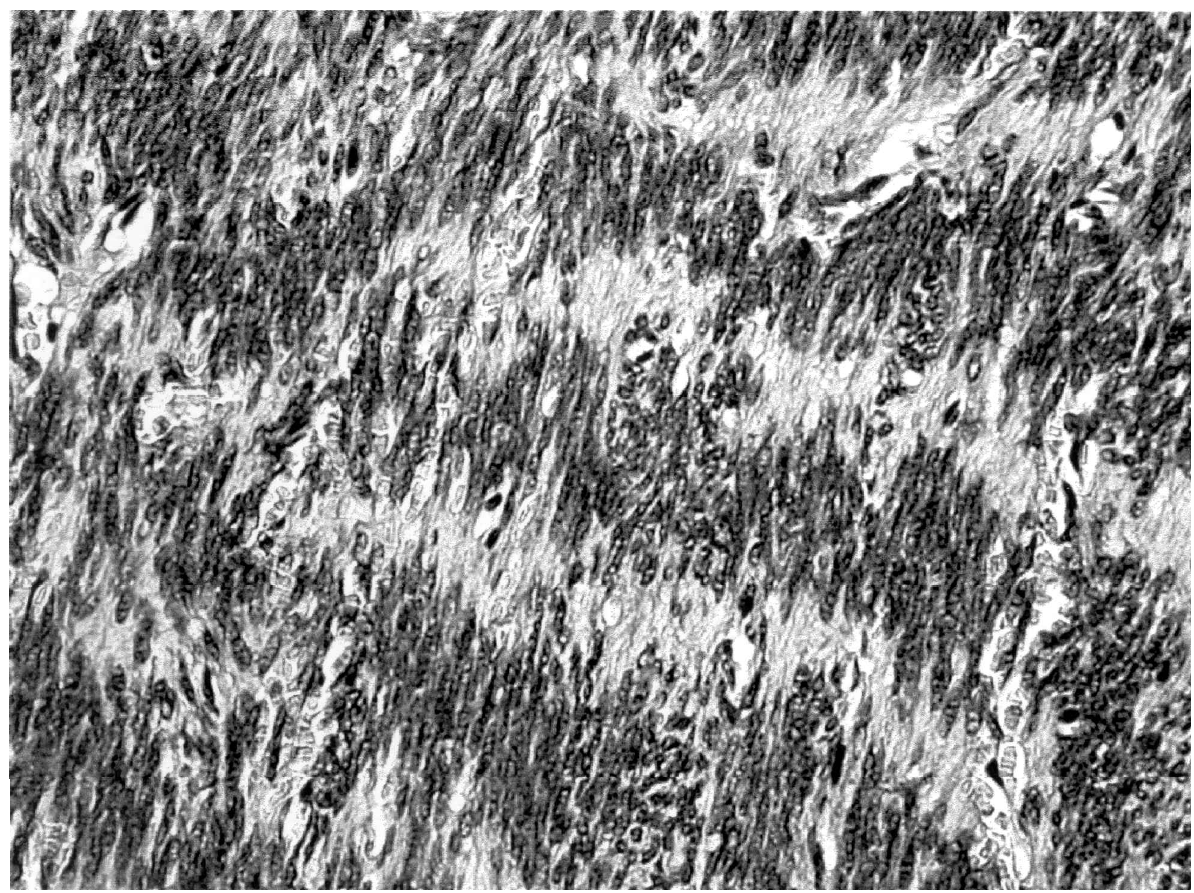
Fig. 2. Higher magni® cation of the cellular schwannoma composed of elongated spindle cells that form a striking palisading